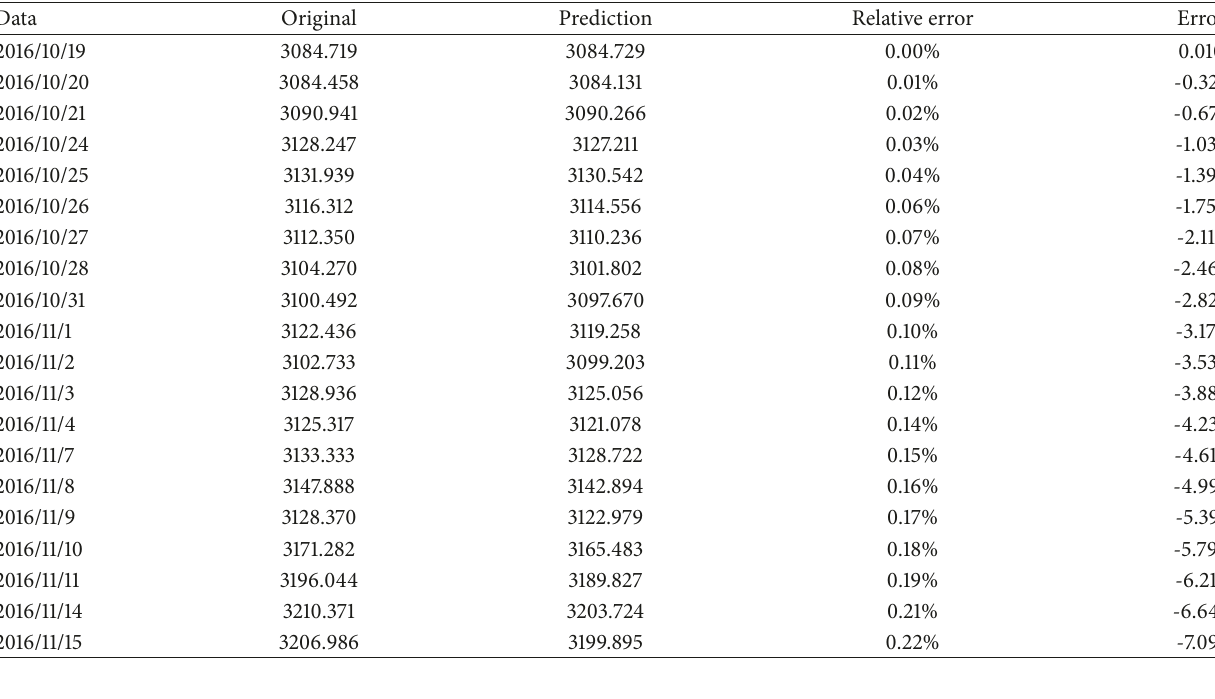
Table 3: Combination prediction results.